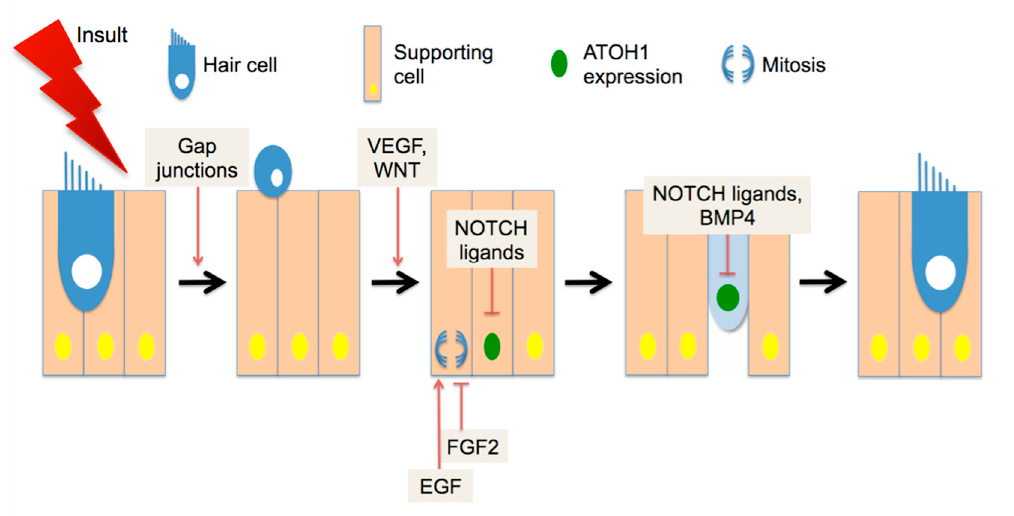
Figure 1. Factors in avian auditory regeneration. Hair cells (HC, blue) are surrounded by supporting cells (tan) in the basilar papilla. After noise or ototoxin exposure, HCs are expelled from the epithelium. VEGF (vascular endothelial growth factor) and / or WNT family factors have been implicated in both supporting cell proliferation and HC di ff erentiation, with the latter process requiring ATOH1 (atonal homologue 1) expression (green nucleus). NOTCH ligands act to down-regulate ATOH1 expression. EGF (epidermal growth factor) ligands and FGF2 (fibroblast growth factor) have opposing e ff ects on proliferation (indicated in blue). After the nascent HC is specified, BMP (bone morphogenic protein) ligands are thought to inhibit further di ff erentiation through the induction of ID (inhibitor of di ff erentiation) proteins. See the text for references.